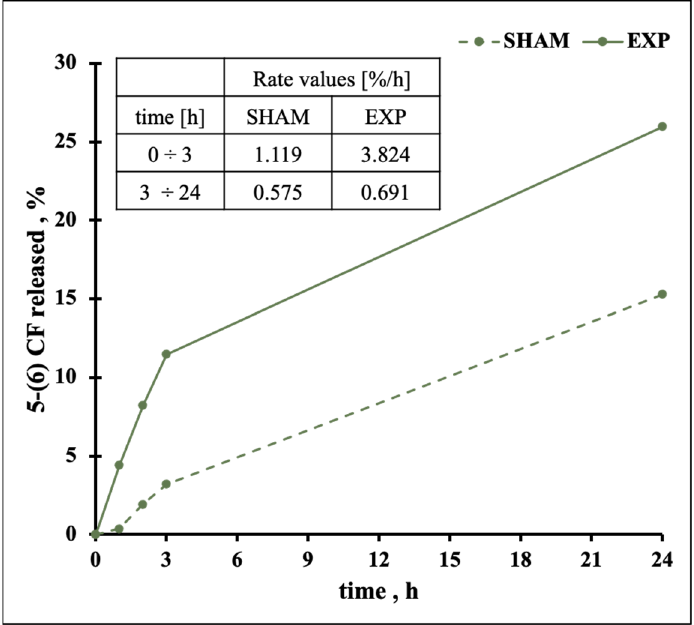
Figure 7. Release from Gel MLs during PEMFs exposure and SHAM condition (3 h) and after 24 h. The inset shows the rate of release for the first 3 h of exposure and for the remaining 24 h without PEMFs.